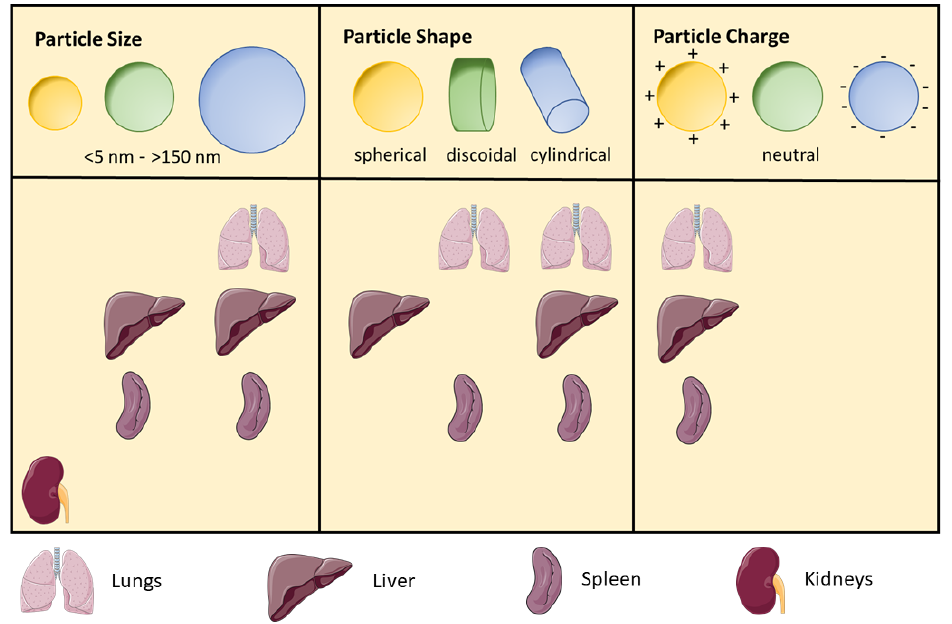
Figure 2. Impact of NP properties on their biodistribution in lungs, spleen, kidneys and liver. Especially NP size, shape and surface charge are dictating the biodistribution. Particles smaller than 5 nm are filtered by the kidneys. With increasing size (20–150 nm) higher amounts of NPs are detectable in liver and spleen. Even more NPs are entrapped in liver, spleen and lungs when the size is over 150 nm. It is said that these NPs are proven for long-lasting circulation [101,102]. Cylindrical shapes seem to be quite favorable because a lot of these NPs are distributed in lungs, liver and spleen but also discoidal forms exhibit high accumulation capacities [103]. Positive surface charges of NPs lead to a prioritized sequestration in lungs, liver and spleen. NPs with slightly negative or neutral surfaces show longer circulation times and lower accumulation in these organs [104]. Regarding the NP shape and surface charge data, it is important to mention that the size of the discussed NPs is said to range from 20 to 150 nm [101].